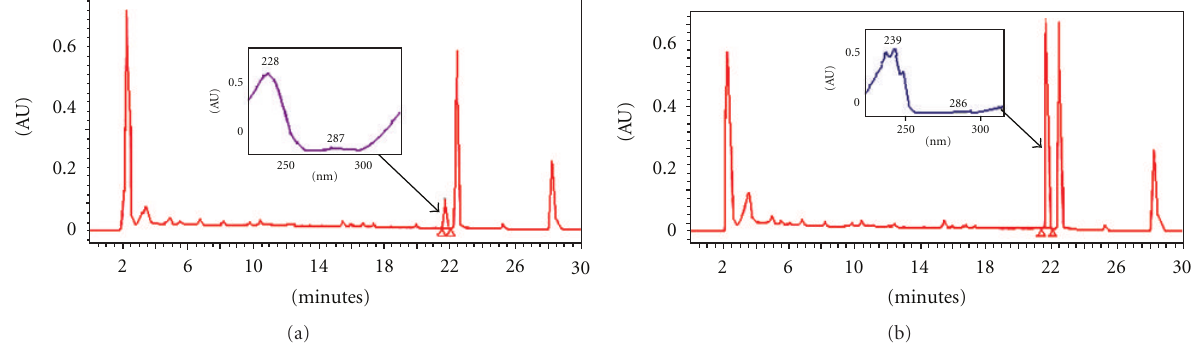
Figure 5: A typical HPLC chromatogram of t MFP using Monascus purpureus FTC5391 mixed with monacolin K as standard solution (STD). (a) HPLC chromatogram profile with UV spectrum before mixing with STD and (b) after mixing with STD. The MFP was produced by submerged fermentation using Hiroi-PDA (sucrose (100g/L), yeast extract (3g/L), casamino acid (5g/L), NaNO 3 (2g/L), KH 2 PO 4 (1g/L), MgSO 4 · 7H 2 O (0.5g/L), KCl (0.5g/L), FeSO 4 (0.01 g/L), potato starch (4g/L), dextrose (20g/L), and agar (15g/L)).